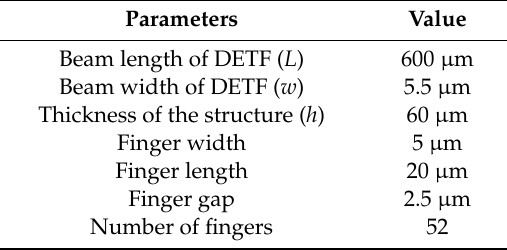
Table 1. Structure parameters of the DETF.